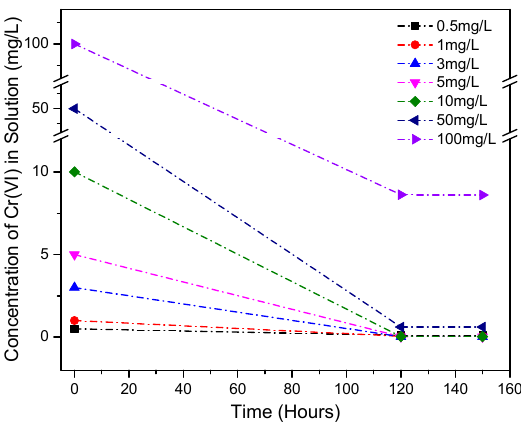
Figure 4. A comparison of the Cr(VI) concentrations in the S3 specimens’ solutions at 0, 120, and 150 h of reaction.